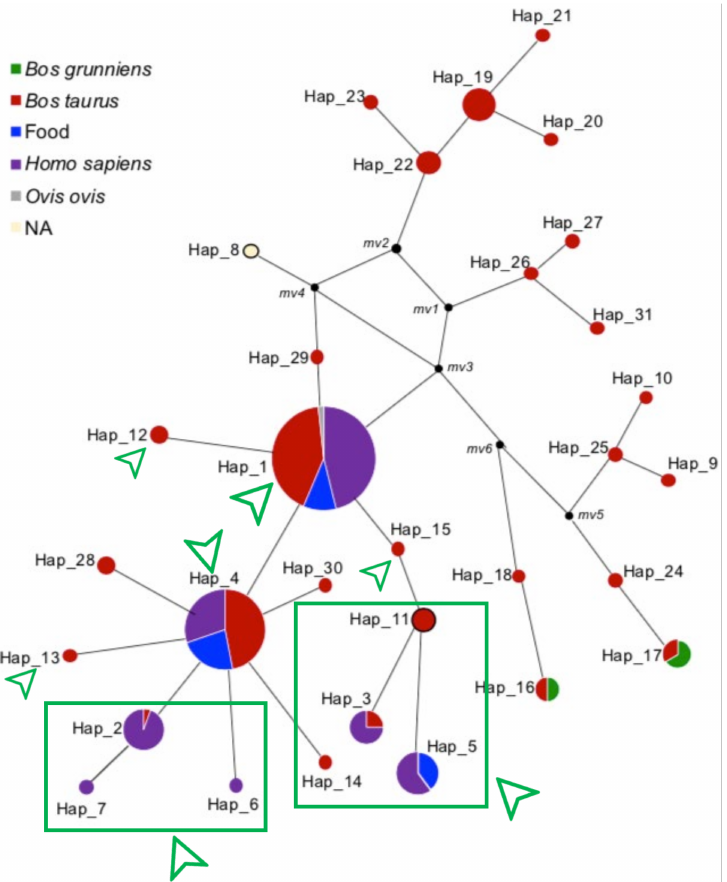
Figure 2. Haplotype network of Bovine Leukaemia Virus (BLV) obtained from the multiple align- ment of the complete data set, performed with Median-Joining tool in Network v.5.0. A total of 31 haplotypes were identified in the analyzed dataset. The size of the circles represents the frequency of the haplotypes in the study. Hap 1 ( n = 117) and Hap 4 ( n = 66) were the most frequent haplotypes. Distances from haplotypes represent the sequence-type differences as regards nucleotide substitu- tions in the data set Colors indicate source of the virus. Red—bovine, Blue—food, Purple—humans. Notice the three colors in Hap 1 and 4. Small black circles were generated automatically to estimate connectors of the analyzed sequences. Haplotypes shown in green squares and arrows indicate those in which Colombian sequences were